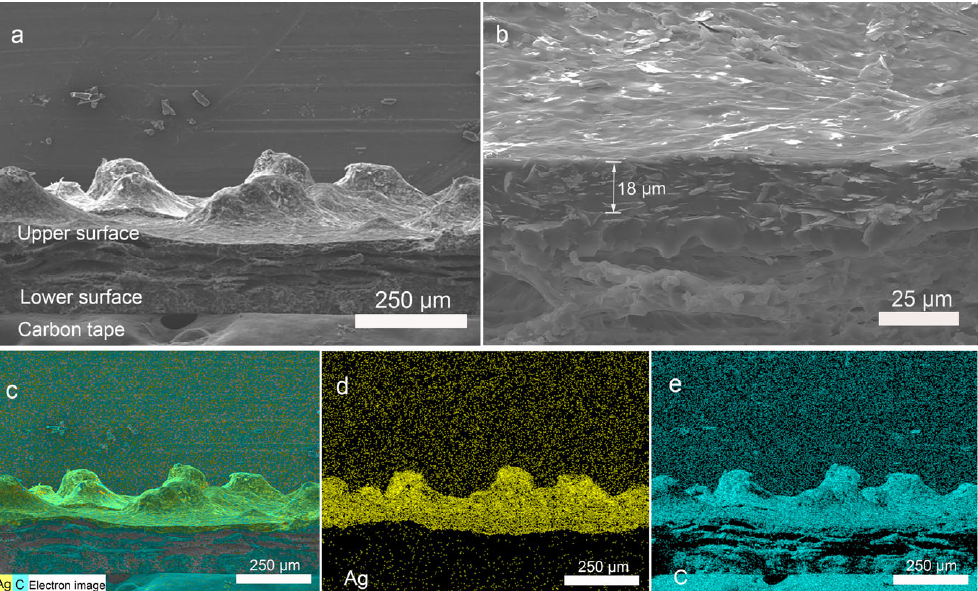
Figure 3. Cross-section SEM images of the PU/Ag film: ( a ) low magnification; ( b ) high magnification. Energy-dispersive X-ray spectroscopy (EDX) mapping of PU/Ag film, including EDX layered image ( c ), element Ag ( d ), and element C ( e ).